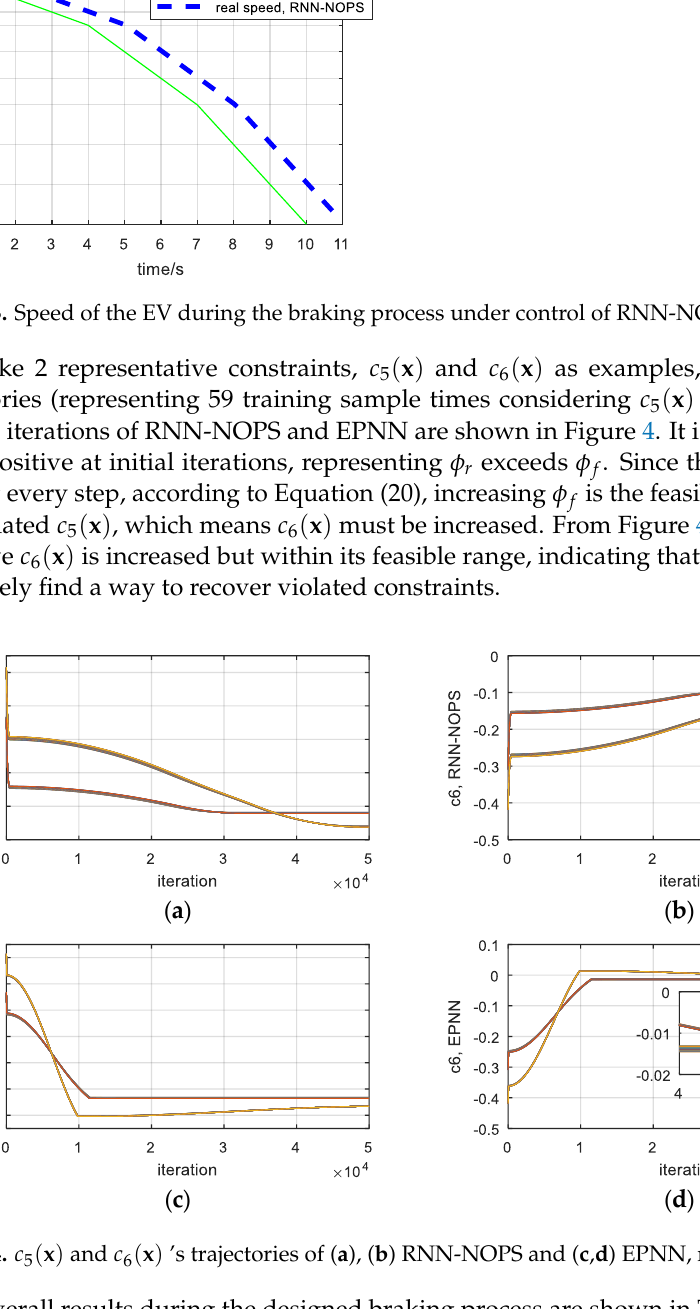
follows the target speed with delay and the overall trends are consistent. Speed following results with EPNN are similar.